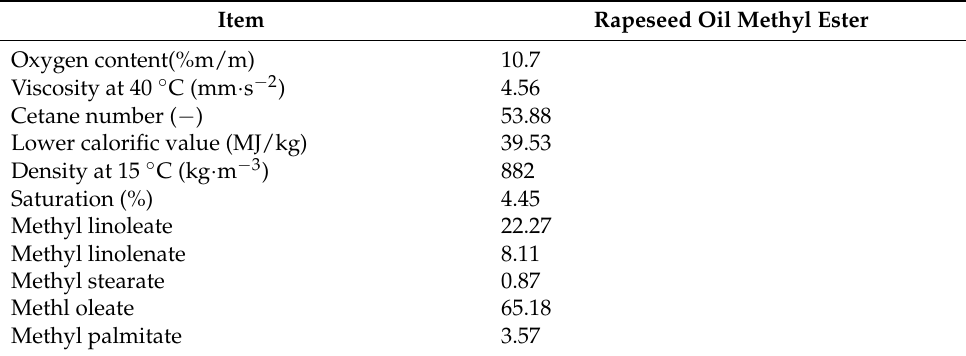
Table 3. Physical properties of fuel.